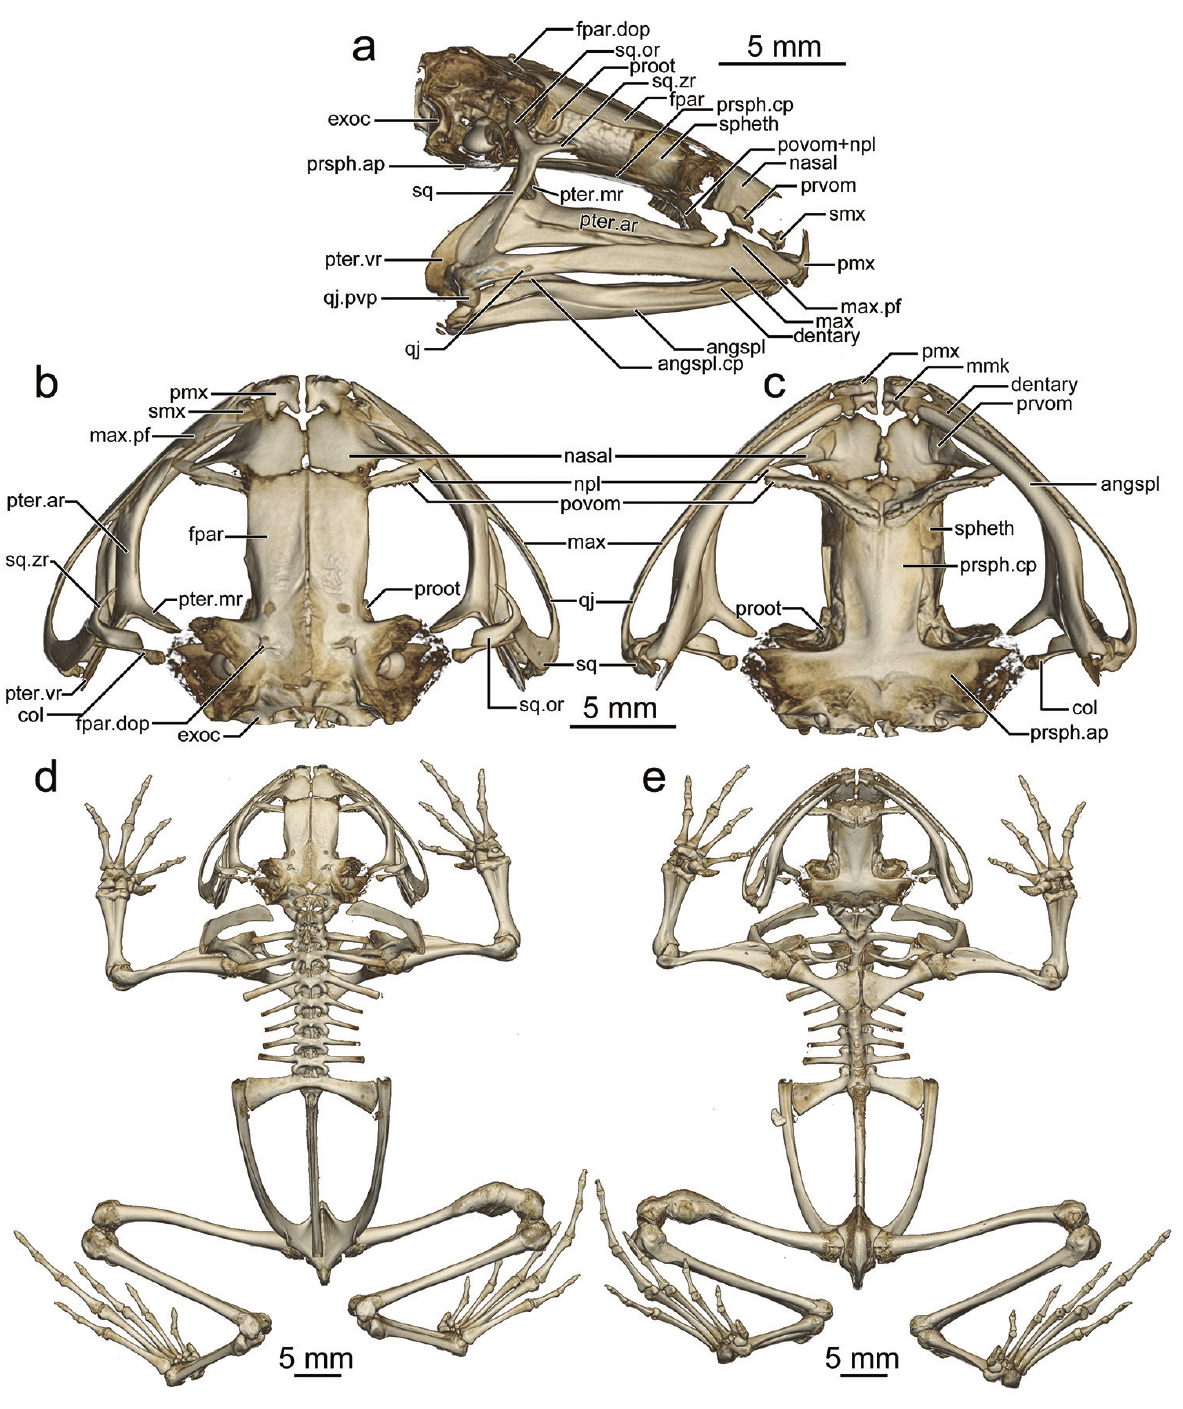
Figure 4. The osteology of Rhombophryne nilevina sp. n. Skull in ( a ) lateral, ( b ) dorsal, and ( c ) ventral view; and full skeleton in ( d ) dorsal and ( e ) ventral view. Abbreviations: angspl, angulosplenial; angspl.cp, angulosplenial coronoid process; col, columella; exoc, exoccipital; fpar, frontoparietal; fpar.dop, frontoparietal dorsal process; max, maxilla; max.pf, maxillary pars fascialis; mmk, mentomeckelian bone; npl, neopalatine; pmx, premaxilla; povom, postschoanal vomer; proot, prootic; prvom, prechoanal vomer; prsph.ap, parasphenoid alary process; prsph.cp, parasphenoid cultriform process; pter.ar, pterygoid anterior ramus; pter.vr, pterygoid ventral ramus; pter.mr, pterygoid medial ramus; qj, quadratojugal; qj.pvp, quadratojugal posteroventral process; smx, septomaxilla; spheth, sphenethmoid; sq, squamosal; sq.or, squamosal otic ramus; sq.zr, squamosal zygotic